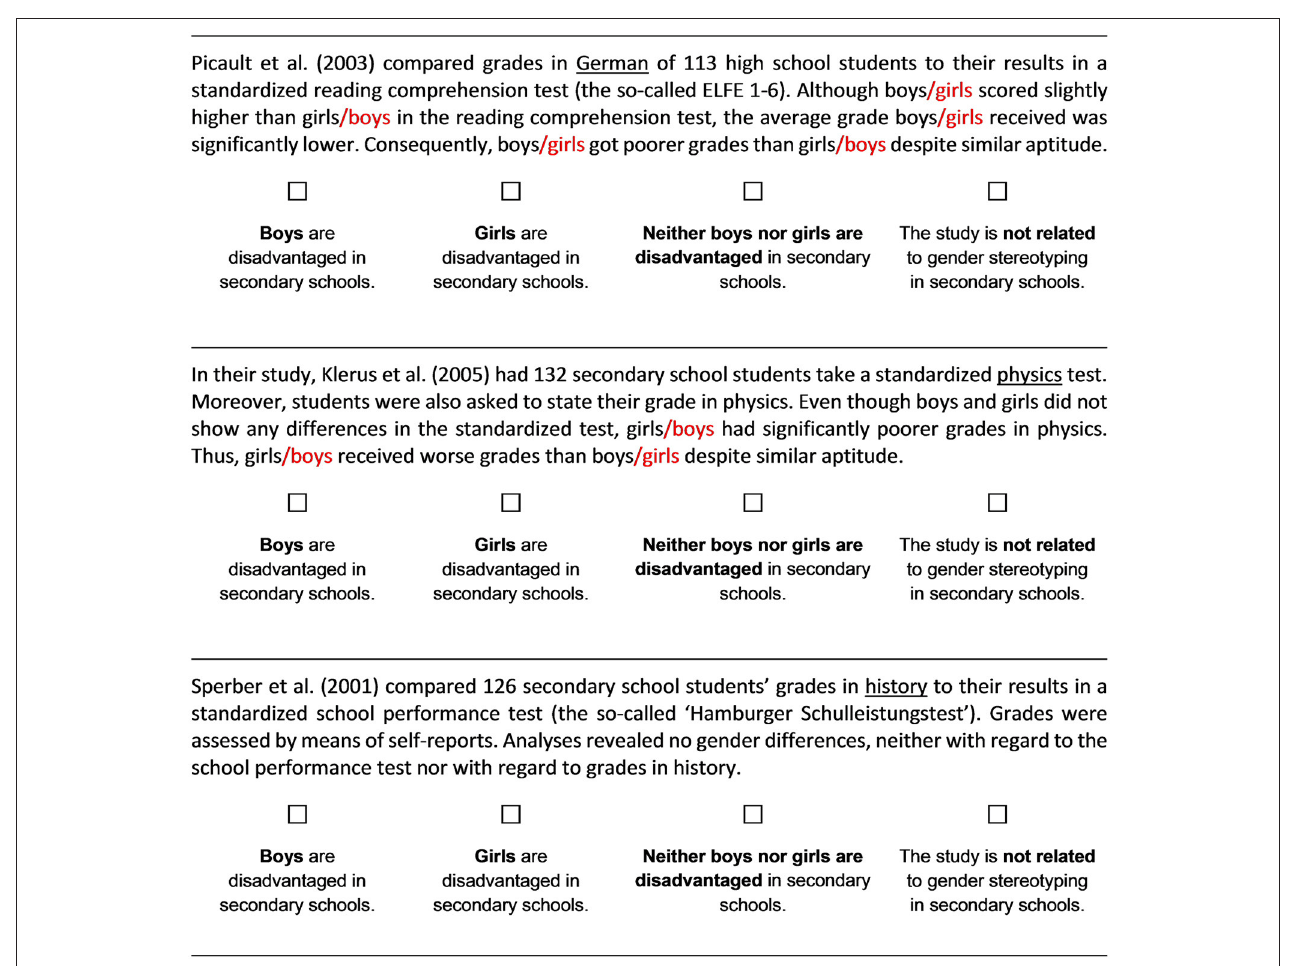
FIGURE 1 | Three resolvable controversies sample texts. Cues allowing to resolve the controversies are underlined and red marks illustrate how texts were modified in the “Unresolvable Read” group (please note that only half of the cues were changed resulting in an overall random pattern of discrimination). The complete German version of the texts is available on